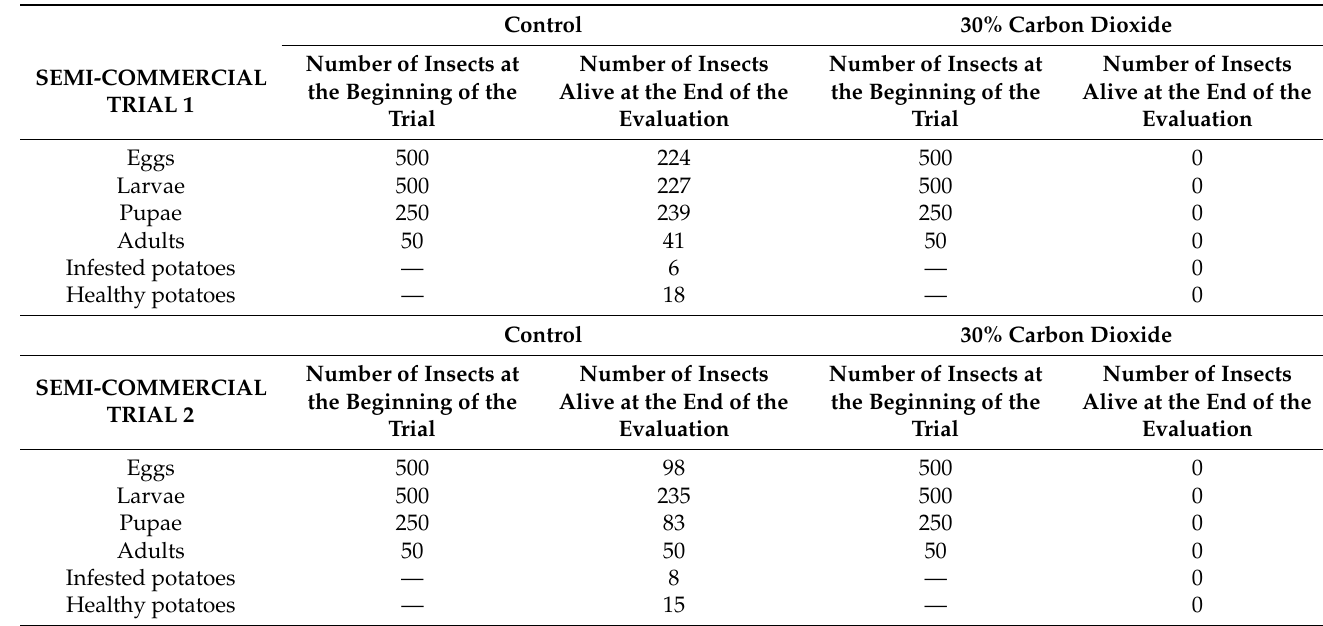
Table 4. Effects of 10 day treatment with 30% CO 2 , 20% O 2, and 50% N 2 controlled atmosphere at 17 ◦ C on survival of Tecia solanivora at different life stages in semi-commercial